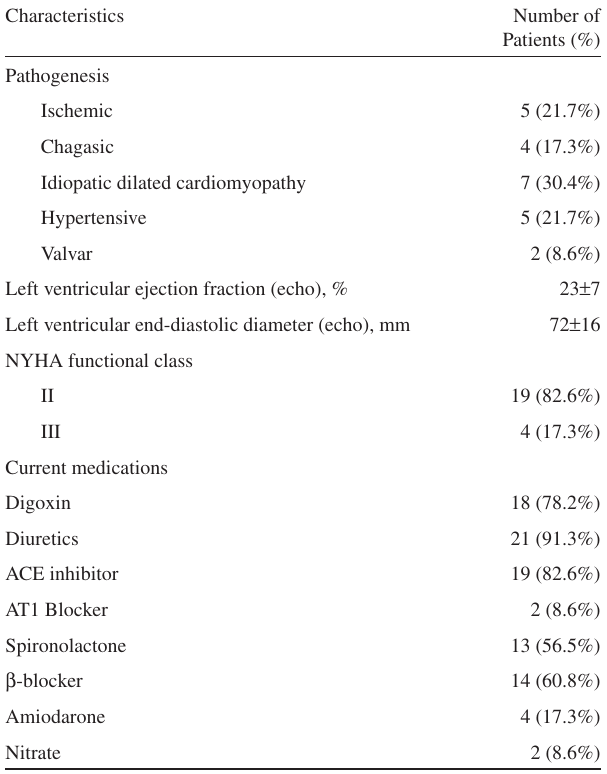
Table 1 - Characteristics of patients